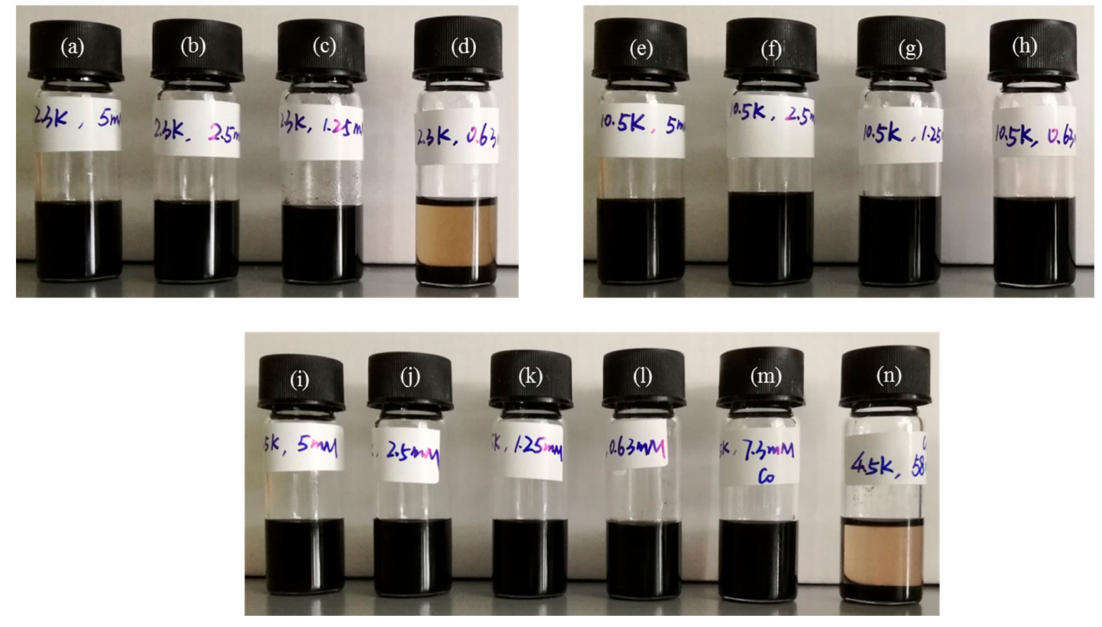
Figure 10. Photographs of PS–Co NPs synthesized at different conditions in